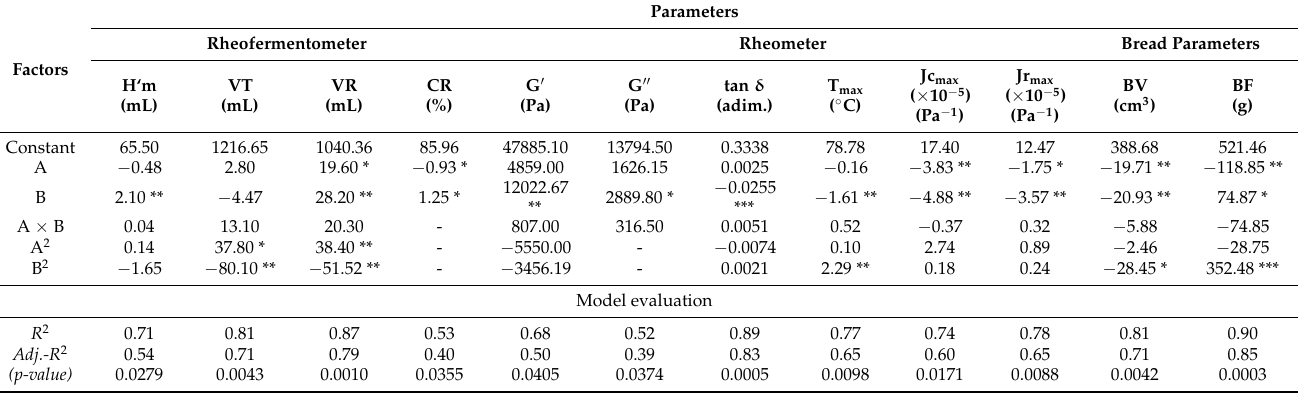
Table 3. The coefficients in the predictive models during dough fermentation, dynamic rheological and bread